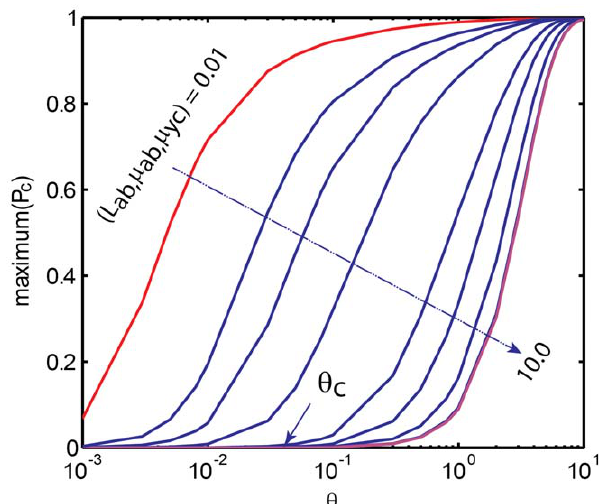
Figure 4. Dependency of the maximum achievable protein product of TF gene C on the width of the input pulse at the promoter of A in case of P-P A-AND-B type FFL (C1 with AND- logic). Here the settings are (cid:2) ww =0.12, (cid:2) vv =0.0003, (cid:2) ss =4, T =25 generation times, and (cid:2) mm was varied as (0.01, 0.03, 0.05, 0.1, 0.3, 0.5, 1, 5 and 10). Beyond (cid:2) mm . 5, there is not much change in the variation of maximum of P c with respect to the pulse width. The cutoff pulse width h c seems to be strongly dependent on the binding parameters (cid:2) mm